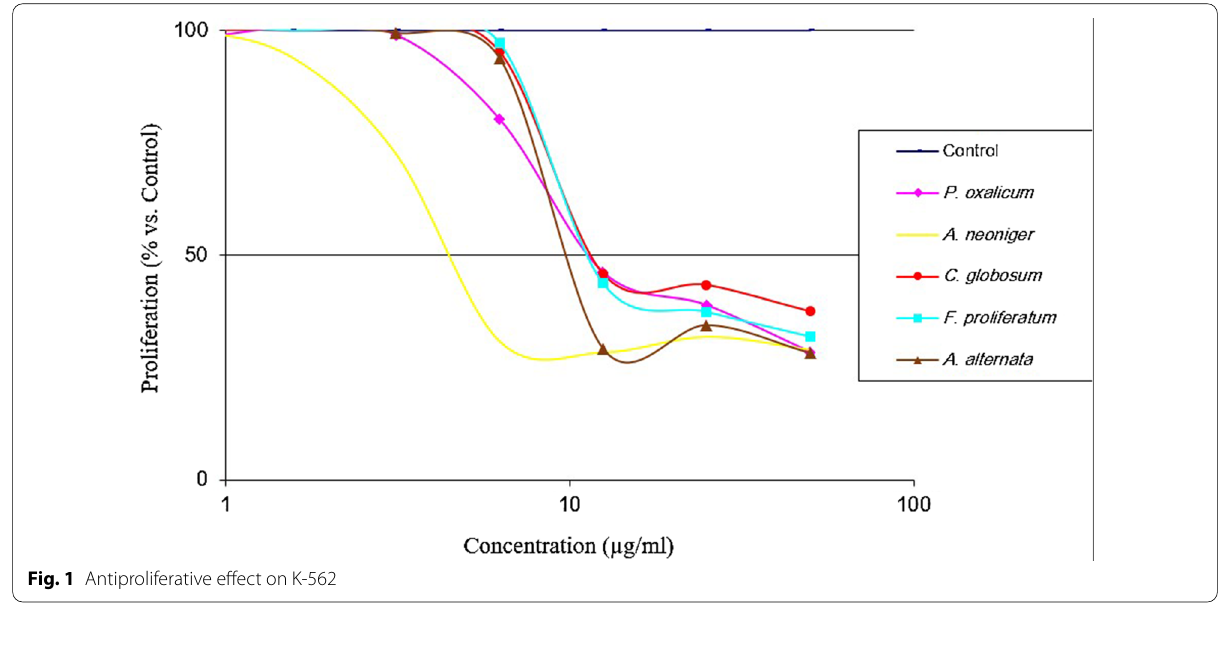
Fig. 1 Antiproliferative effect on K-562